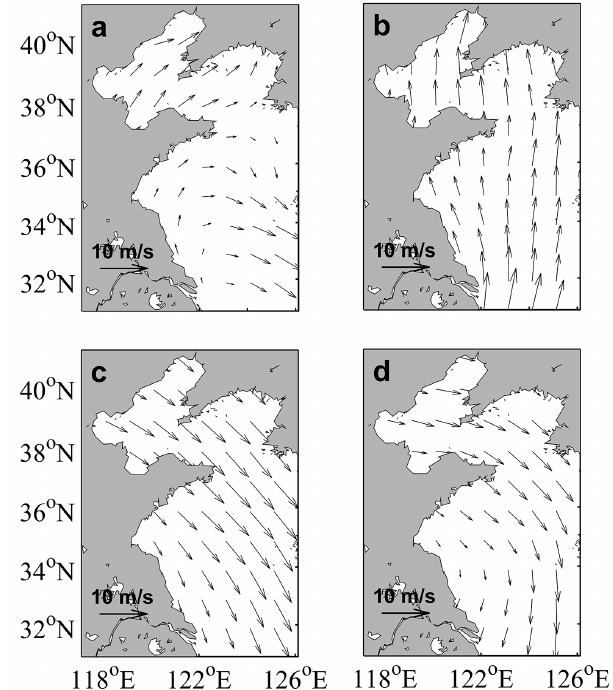
Figure 9. Mean wind velocity during four cruises for ( a ) spring; ( b ) summer; ( c ) autumn; ( d ) winter. The wind data was retrieved from http://www.remss.com/.